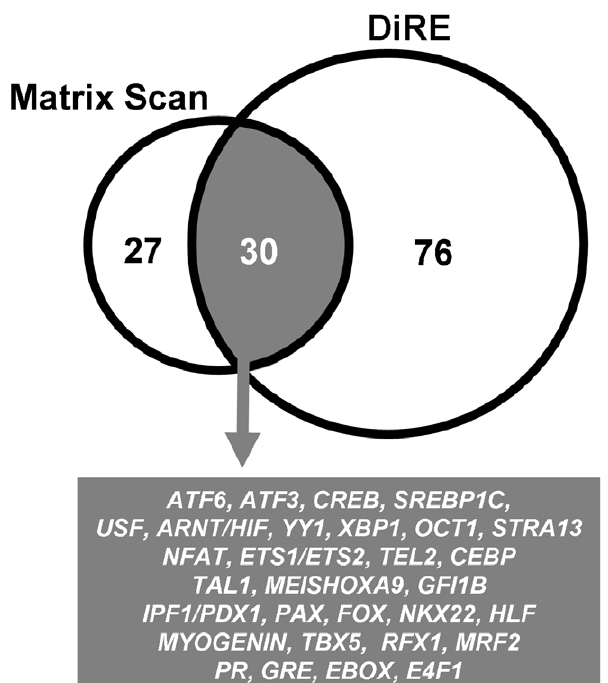
Figure 6. Transcription factor binding sites overrepresented in the conserved beta cell marker gene set. Using two complemen- tary search algorithms (Matrix Scan and DiRE), upstream promoter regions were scanned for statistical enrichment of TRANSFAC-annotat- ed transcription factor binding consensus sites. Venn diagrams indicate number of identified matrices by each program, and with 30 commonly identified matrices indicated in gray field. See Tables S3 and S4.